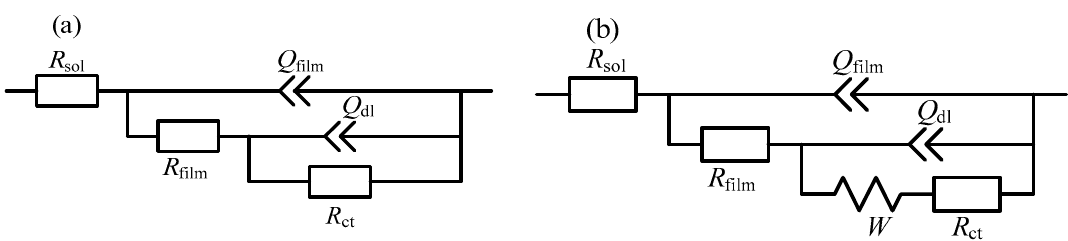
Figure 9. Equivalent electrical circuits used to fit electrochemical impedance spectra (EISs) in Figure 8: ( a ) for 30 min, 1 h, 2 h and ( b ) for 2, 4, 6, 8, 10 and 12 h. Table 1. Calculated parameters for equivalent circuit components in Figure 9.